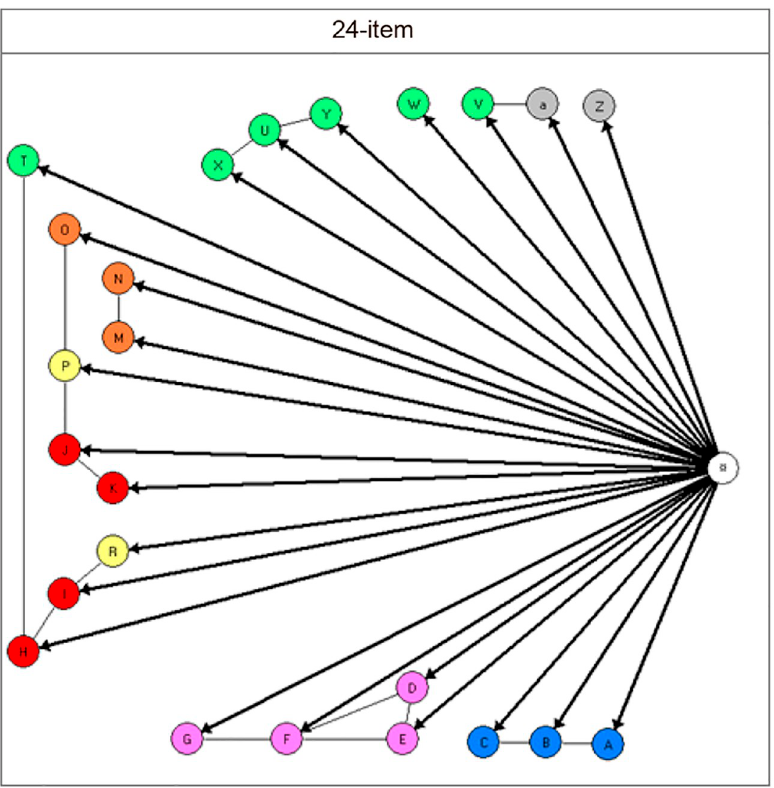
Fig 1. The graphical loglinear Rasch model for the 24-item scale. Note: The colour code signifies items from the seven different domains in CIMHQ: Blue: Sleep regulation (items A,B,C). Purple: Eating (items D,E,F,G). Red: Expression of emotions (items H,I,J,K). Orange: Concentration, attention and distractibility (items M,N,O). Yellow: Motor activity (items P,R). Green: Communication and interaction (items T,U,V,W,X,Y). Gray: Language (items Z,a). Connections between items signify that these items are locally